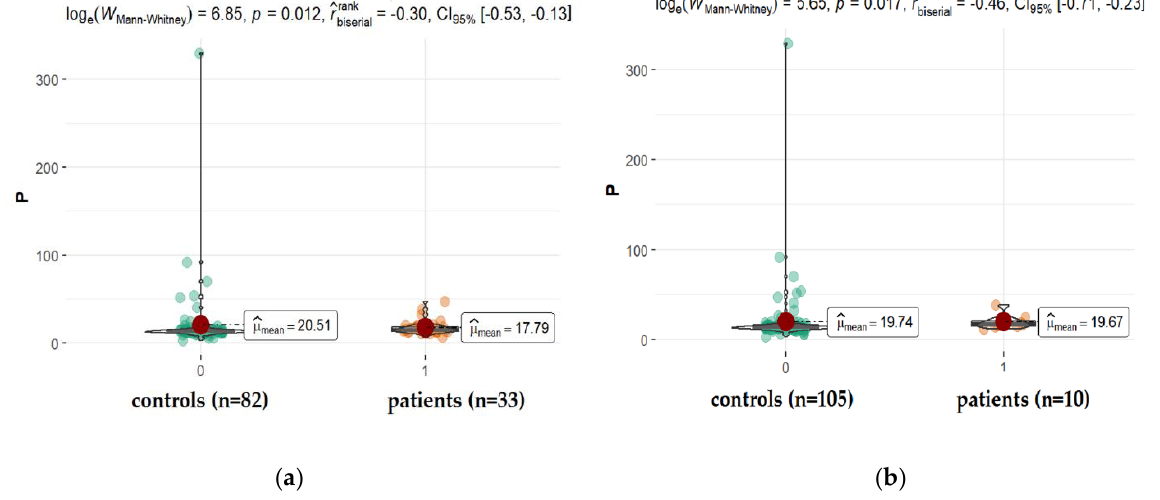
( b ) Figure 7. Statistical significance of differences in P content in AH of patients with coexisting diabetes ( a ), and retinopathy ( b ) compared to controls. A much better parameter reflecting the metabolism of phosphorus in the body, which eliminates these individual differences, is the measurement of the P/Ca ratio. It was con- firmed that the high concentration of serum phosphorus in diabetics is a result of renal